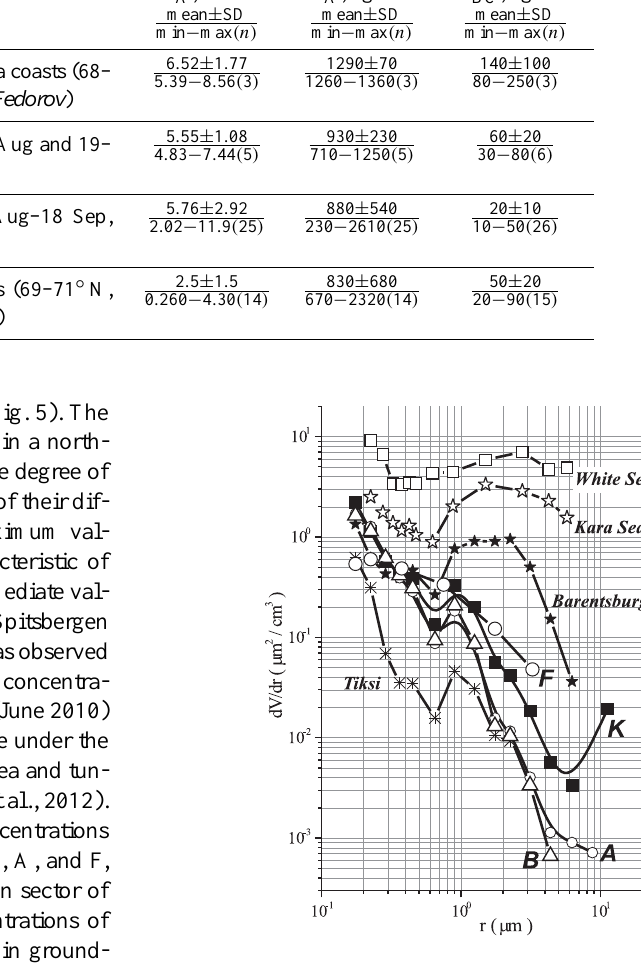
Figure 5. The average volume distributions of aerosol particles d V/ d r in the regions K, B, A, and F as compared to analogous data in the White and Kara seas, in Tiksi, and Barentsburg (Sakerin et al.,